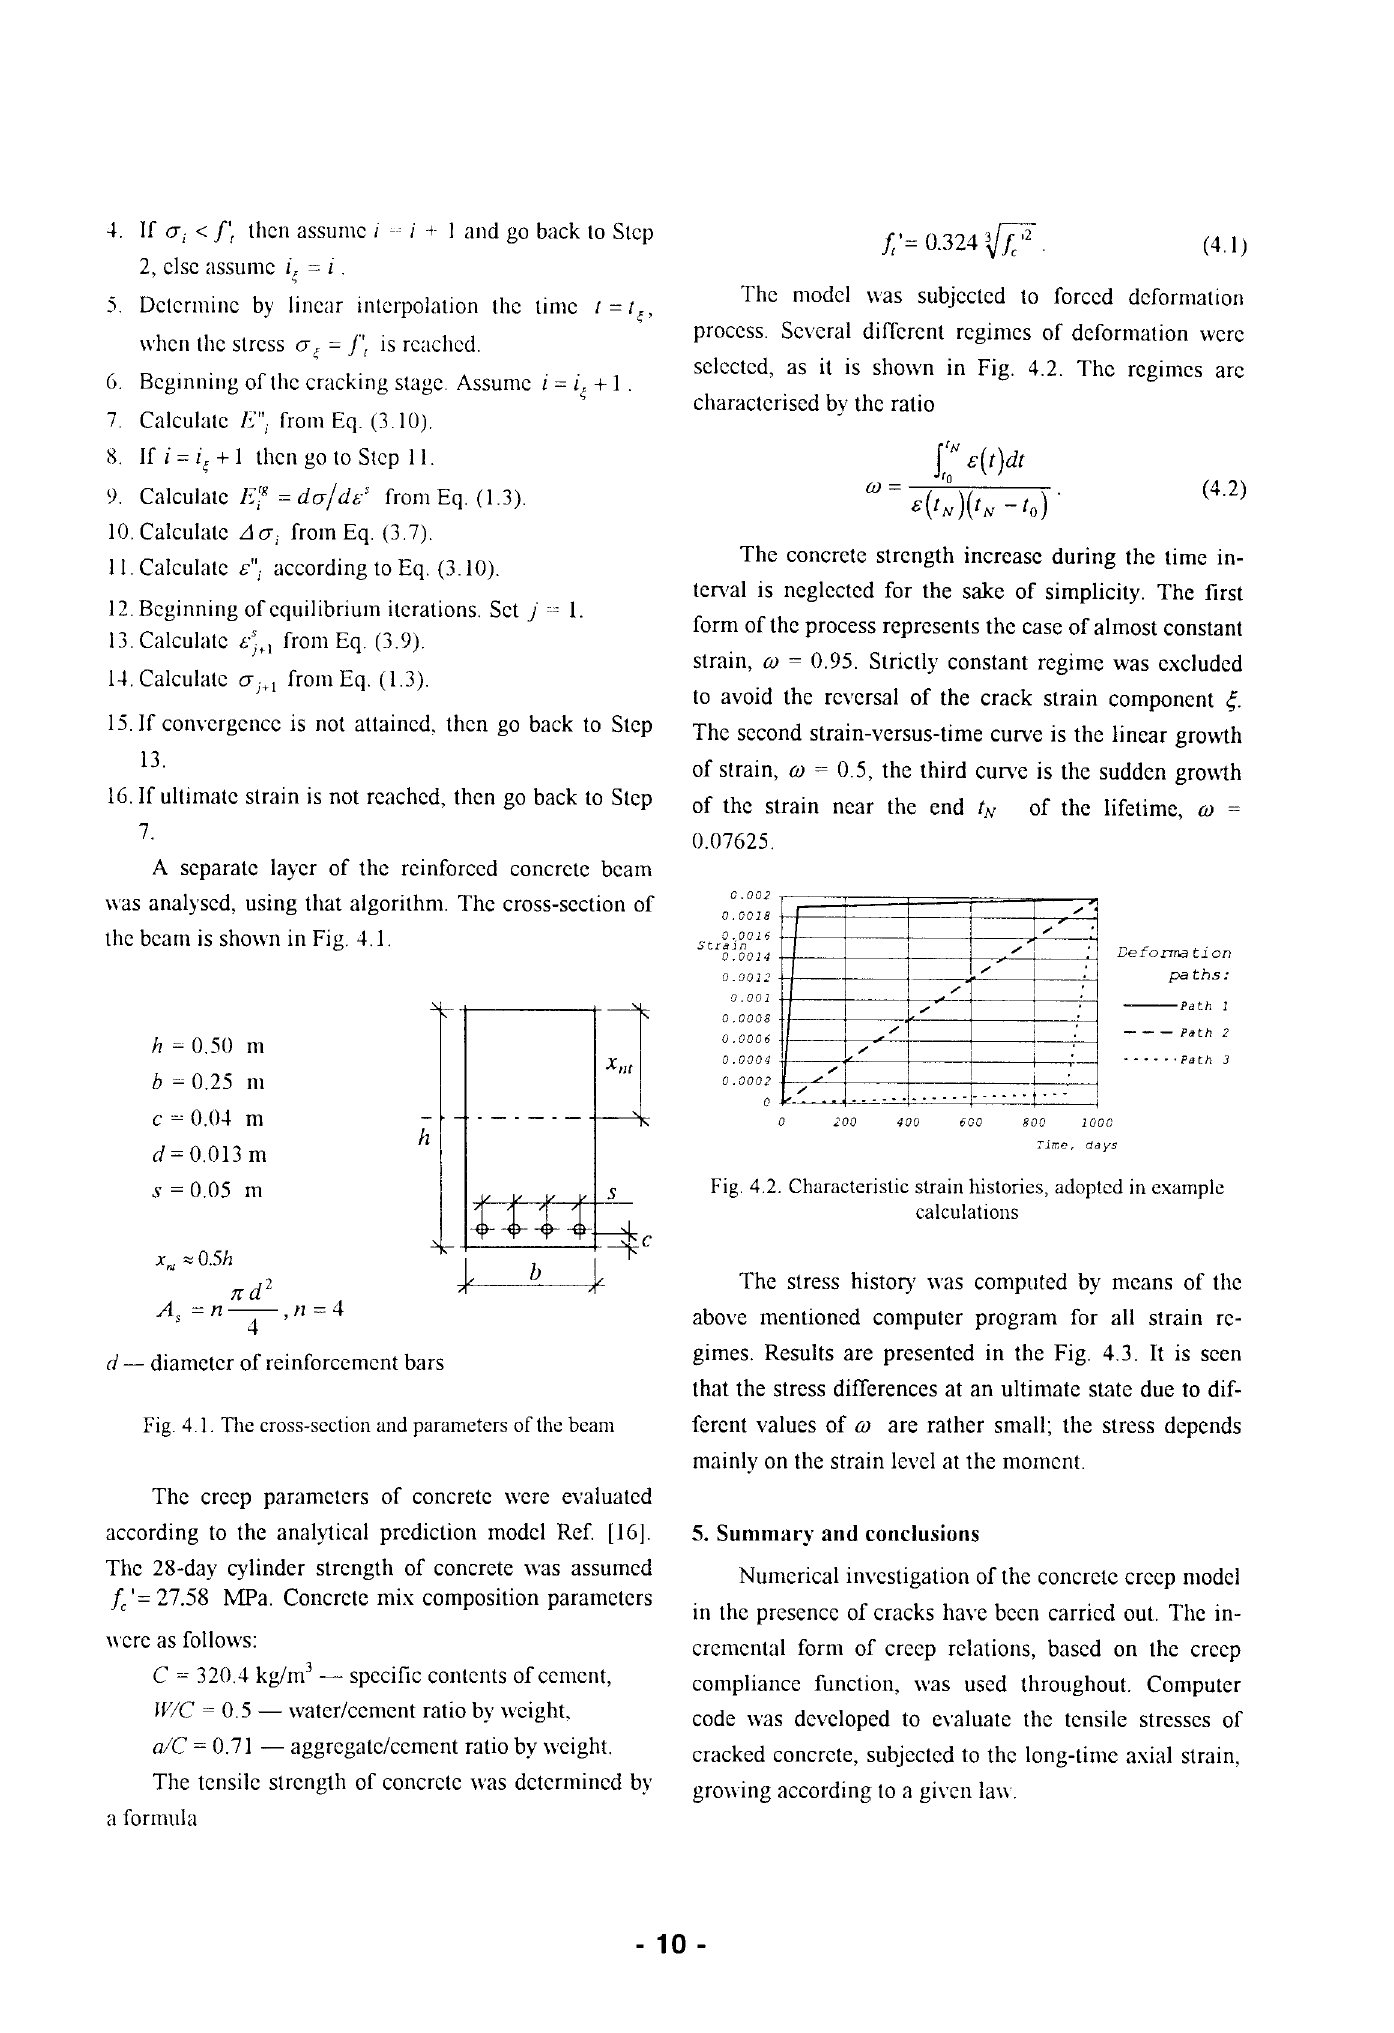
Fig. 4.2. Characteristic strain histories, adopted in